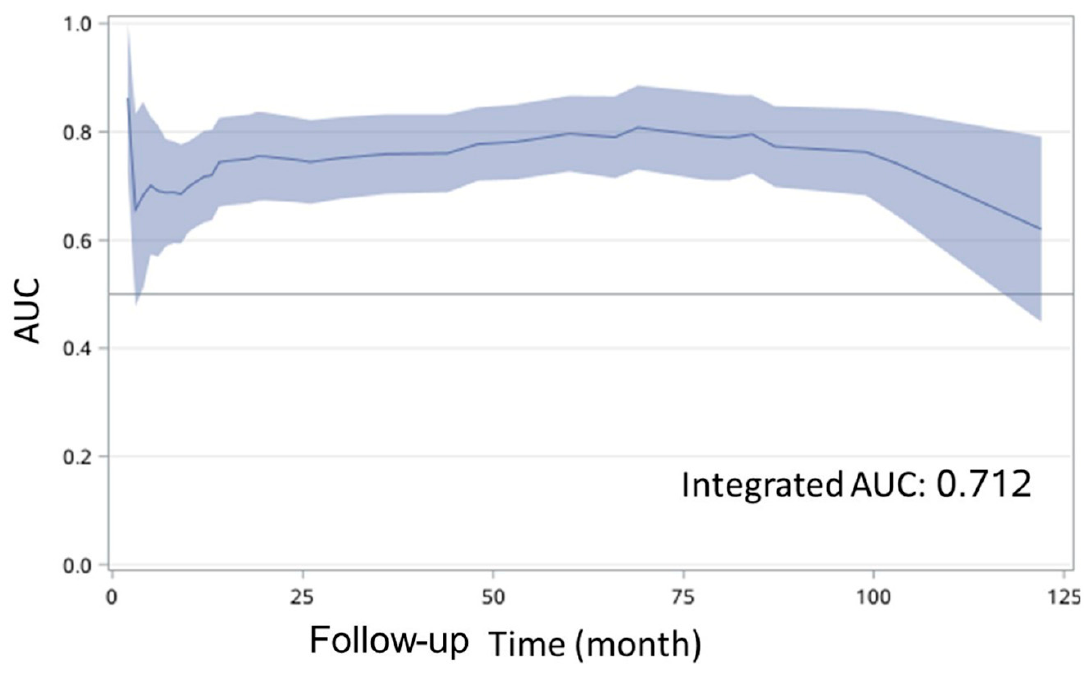
Figure 3. Time-dependent receiver operating characteristic (ROC) curve for disease free survival. AUC, area under the curve.